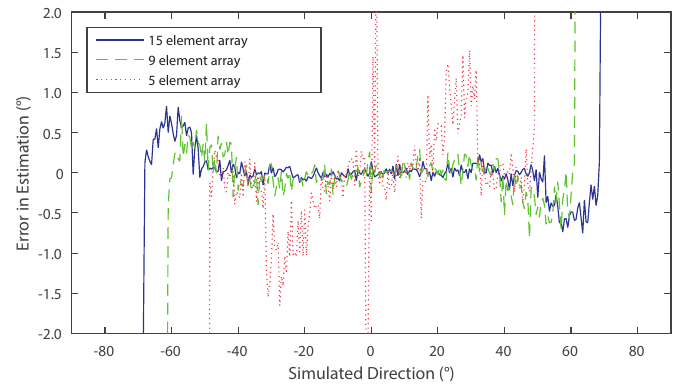
Figure 7. Simulated error in direction of arrival estimation with three different numbers of elements in the presence of noise. Each test had 1350 samples taken from an array with five (dotted), nine (dashed) or fifteen (solid) elements, where the source signal to noise ratio was 10